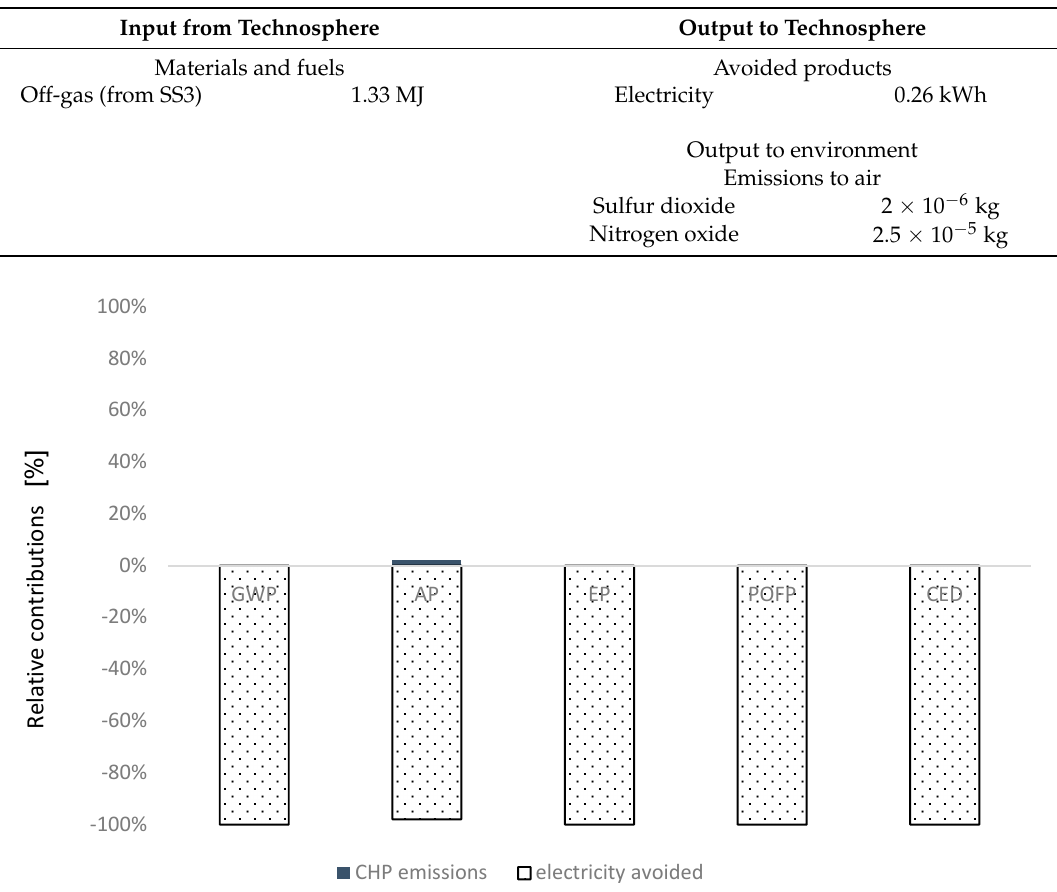
Table 8. Global inventory data (per 1 MJ H2 ) for Subsystem 4.